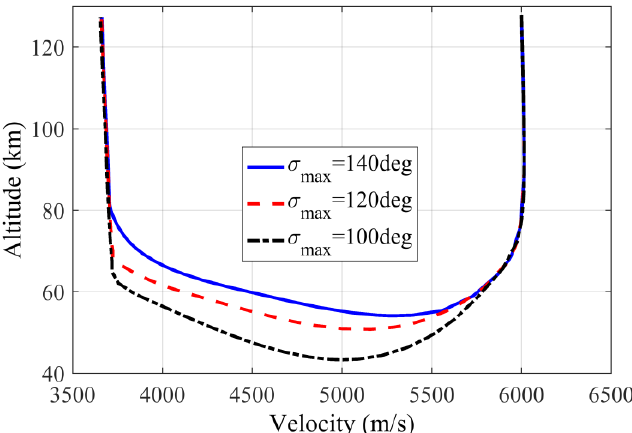
Figure 9. Altitude vs. velocity histories with different upper bounds in terms of the bank angle.